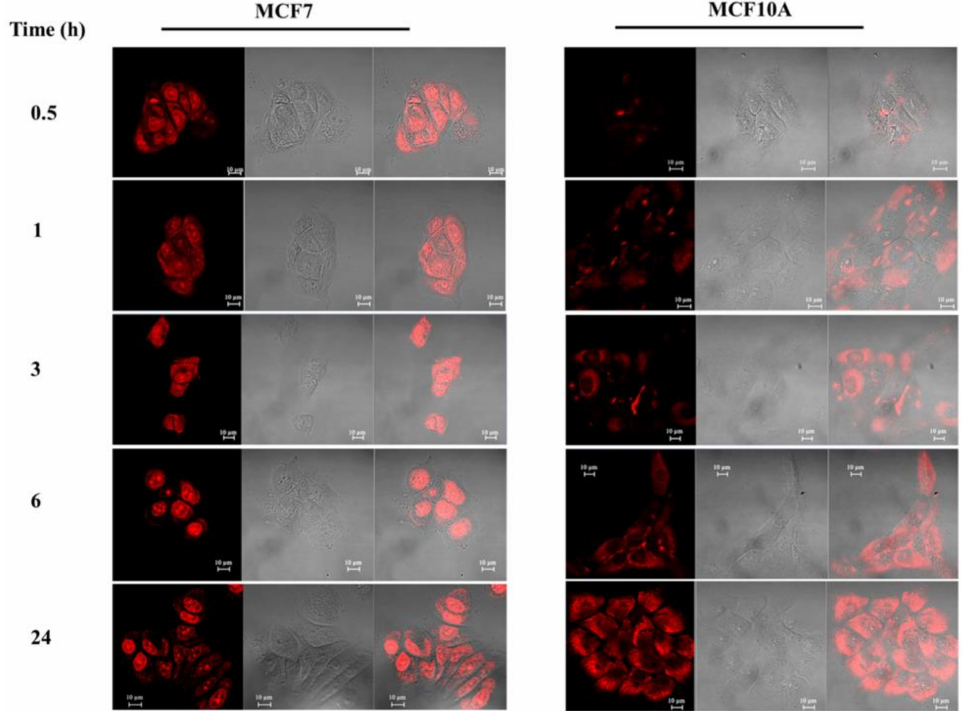
Figure 10. Internalisation of c ex -NDI into MCF7 and MCF10A cells. Cells were cultured on glass coverslips in 24-well plates, grown to semi-confluency and incubated for 0.5, 1, 3, 6 and 24 h with 1.25 µ M c ex -NDI . After fixing the cells with 4% paraformaldehyde, they were analysed by CLSM by using a 63x oil immersion objective. Scale bars correspond to 10 µ